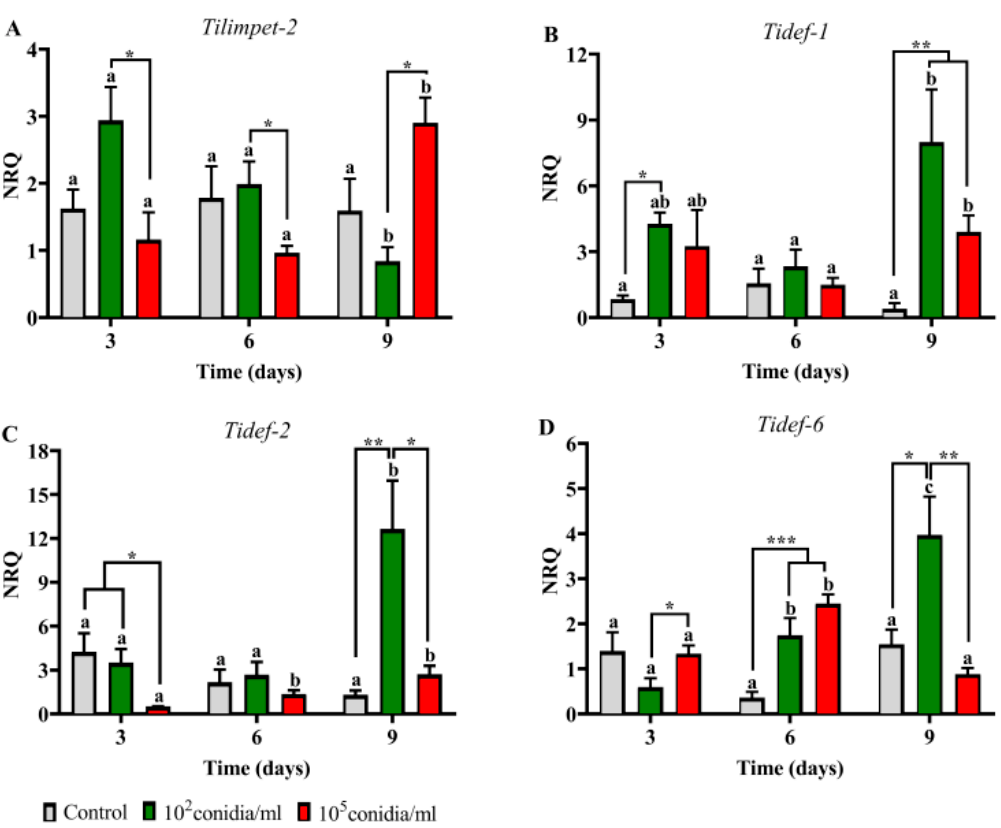
Figure 6. Expression pattern of limpet ( A ) and defensin ( B – D ) genes in Beauveria bassiana -infected pyrethroid-susceptible nymphs of Triatoma infestans . Normalized relative quantities (NRQ) are shown at different time periods after insect immersion in conidial suspensions. Values are means of three replicates ± SEM. For each gene, different letters indicate significant differences for each treatment through time. Asterisks indicate significant differences in gene expression at each time point. * p < 0.05; ** p < 0.005; *** p < 0.0005.